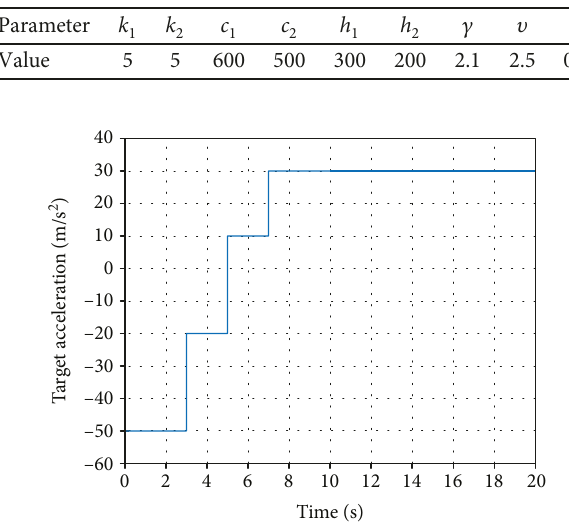
Figure 2: The target maneuver in case